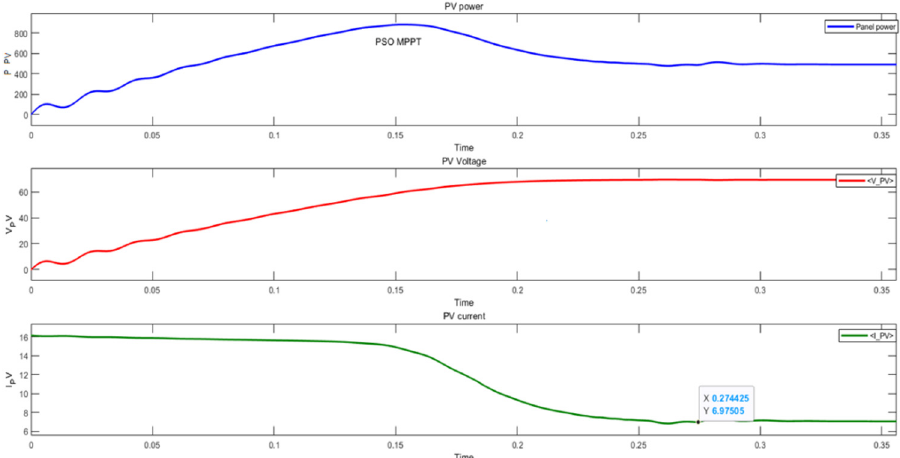
Figure 13. PV power, PV voltage and PV current responses of solar PV panel with the adaptive LMS MPPT controller under solar radiation = 1000 W/m2, T = 30 °C (deg. Celsius), load R = 100 ohms.